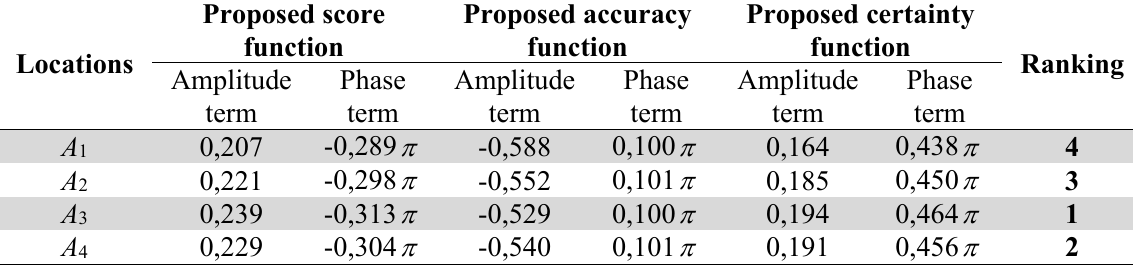
Modified score function of each